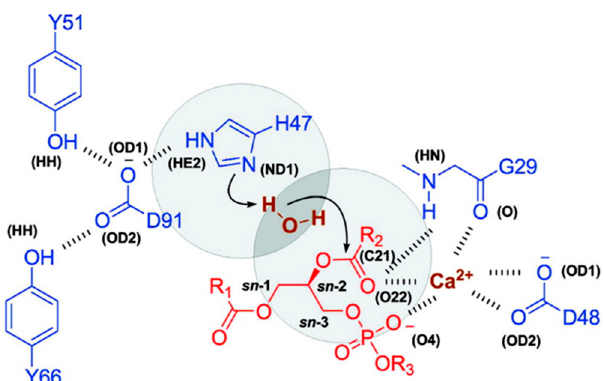
Figure 5. Site of PLA 2 with protein residues (blue), substrate (red), calcium, and water (brown). The H–S region is represented in circles. Types of atoms in brackets are taken from the Protein Data Bank. Reproduced with permission from the authors of [50].